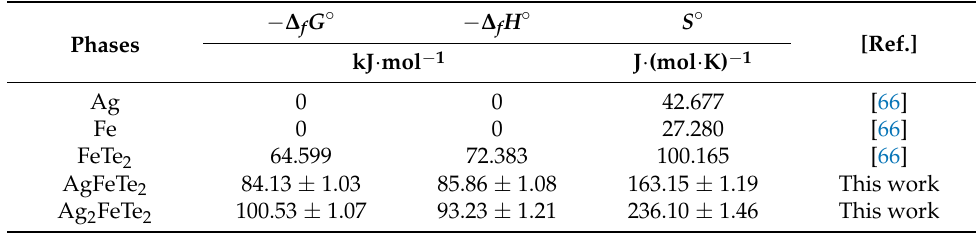
Table 4. A summary of the standard thermodynamic quantities of selected phases in the Ag–Fe–Te system at 298